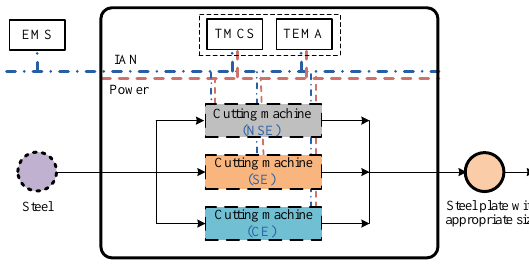
Figure 4. The internal structure of the automatic cutting system (ACS).